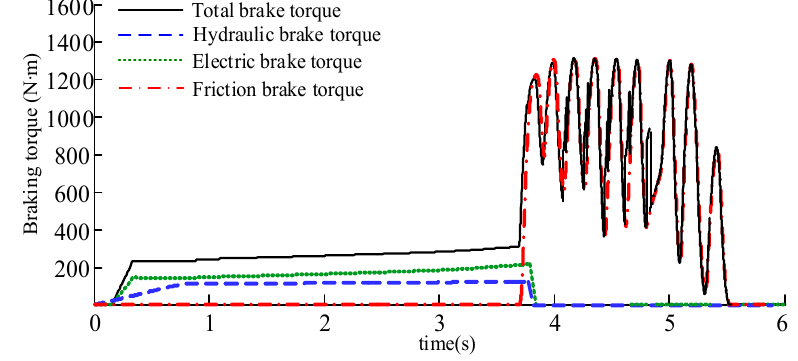
Figure 19. Brake torque distributions and their variation in the front axle.